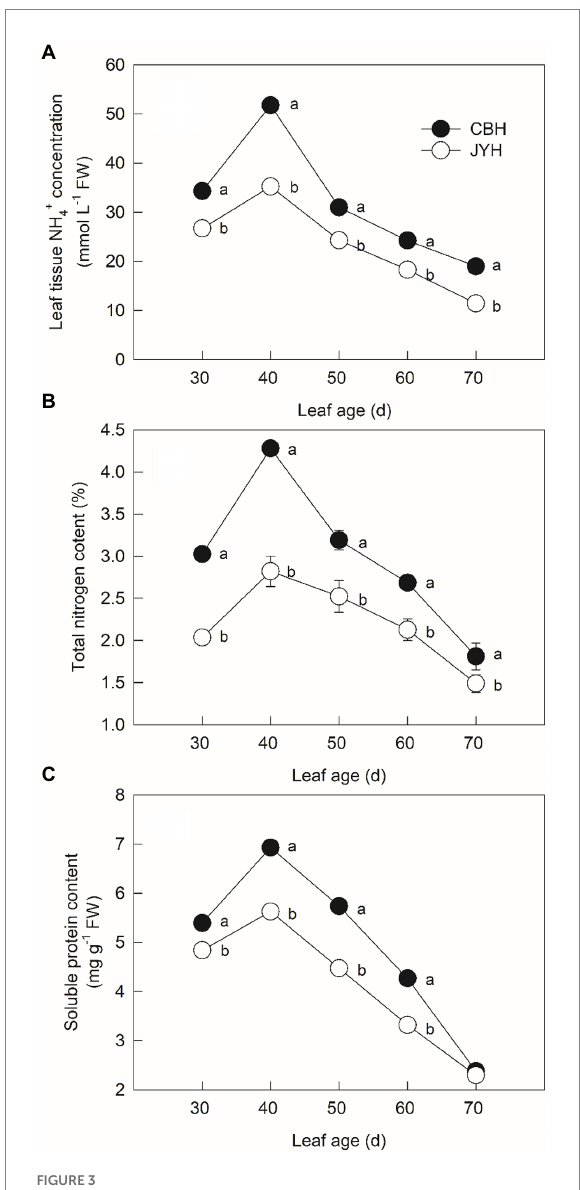
FIGURE 3 Leaf tissue NH 4+ concentration (A) and contents of total nitrogen (B) and soluble protein (C) in resistant and susceptible tobacco cultivars to Alternaria alternata . Values with different letters are significantly different ( p ≤